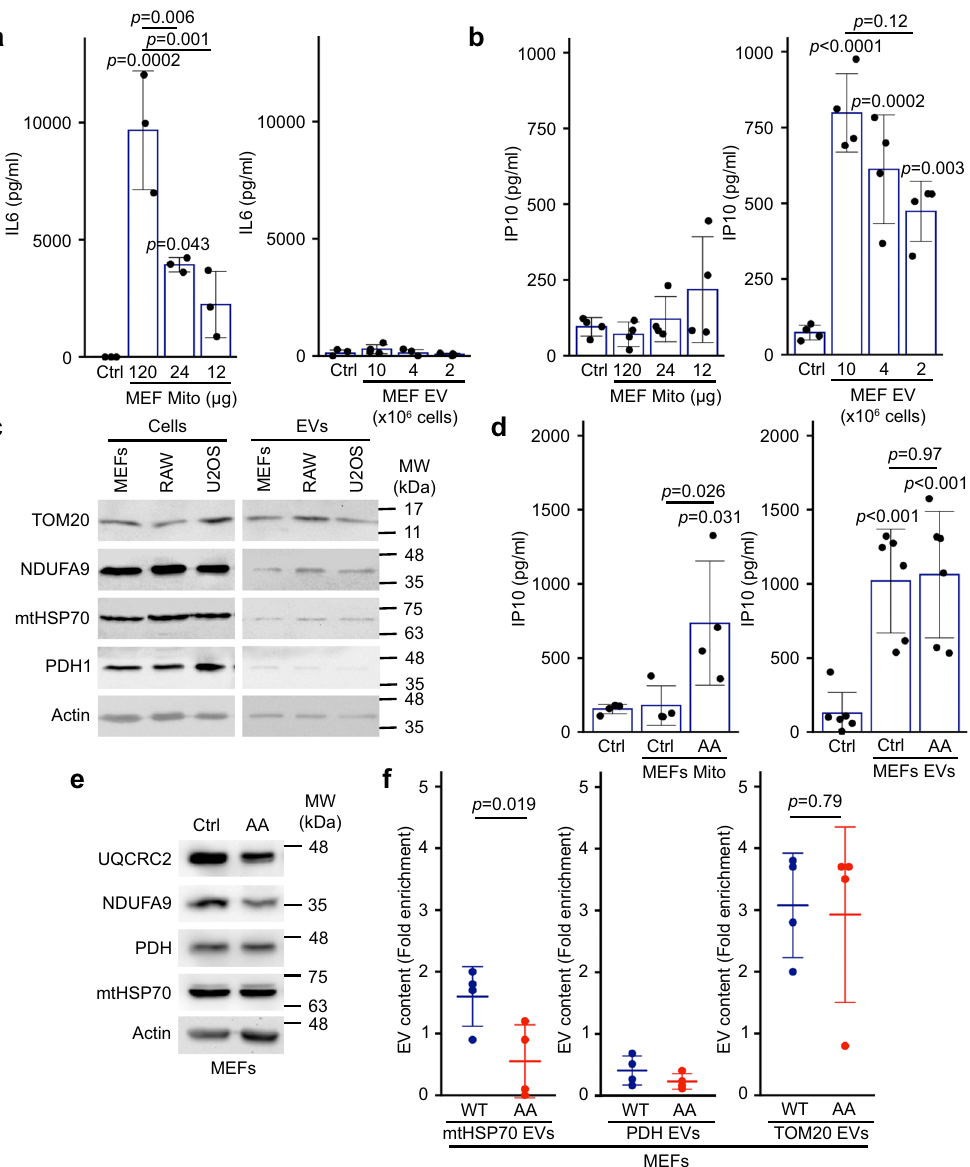
Fig. 1 Mitochondria and EVs activate distinct pro-in fl ammatory cytokines. a , b Extracellular mitochondria induce the secretion of pro-in fl ammatory cytokines. Mitochondria (Mito)(isolated from MEFs) or EVs (isolated by differential centrifugation from the media of MEFs grown for 24 h in EV-depleted media) were added to RAW cells in their culture media. The release of IL6 ( a ) and IP10 ( b ) into culture media was measured by ELISA 24 h. Individual points represent independent experiments ( a , n = 3; b , n = 4). Bars show the average ± SD. One-way ANOVA. c Representative western blot showing the amount of the speci fi ed mitochondrial proteins in the indicated cell types (20 µ g) vs their EVs (5 µ g). TOM20, outer membrane protein; NDUFA9, Complex I subunit; mtHSP70 matrix protein associated with the IM; PDH, matrix protein. Actin is used as a control, as it has been shown to associate with EVs. d AA-treated MEFs mitochondria stimulate IP10 production. RAW cells were treated as above with EVs (from 10 × 10 6 cells) and mitochondria (12 µ g) isolated from Control or AA-treated MEFs, and IP10 release in culture media measured by ELISA. Individual points represent independent experiments (mitochondria, n = 4; EVs, n = 6). Bars show the average ± SD. One-way ANOVA. e AA treatment of WT MEFs causes the selective degradation of mitochondrial proteins. MEFs were treated with AA for 24 h and the indicated mitochondrial proteins analysed by western blot. f Enrichment of the indicated mitochondrial proteins in EVs was measured by western blot in Control (blue) and AA-treated (24 h, Red) WT MEFs. Individual points represent independent experiments ( n = 4). Bars show the average ± SD. Two-sided t